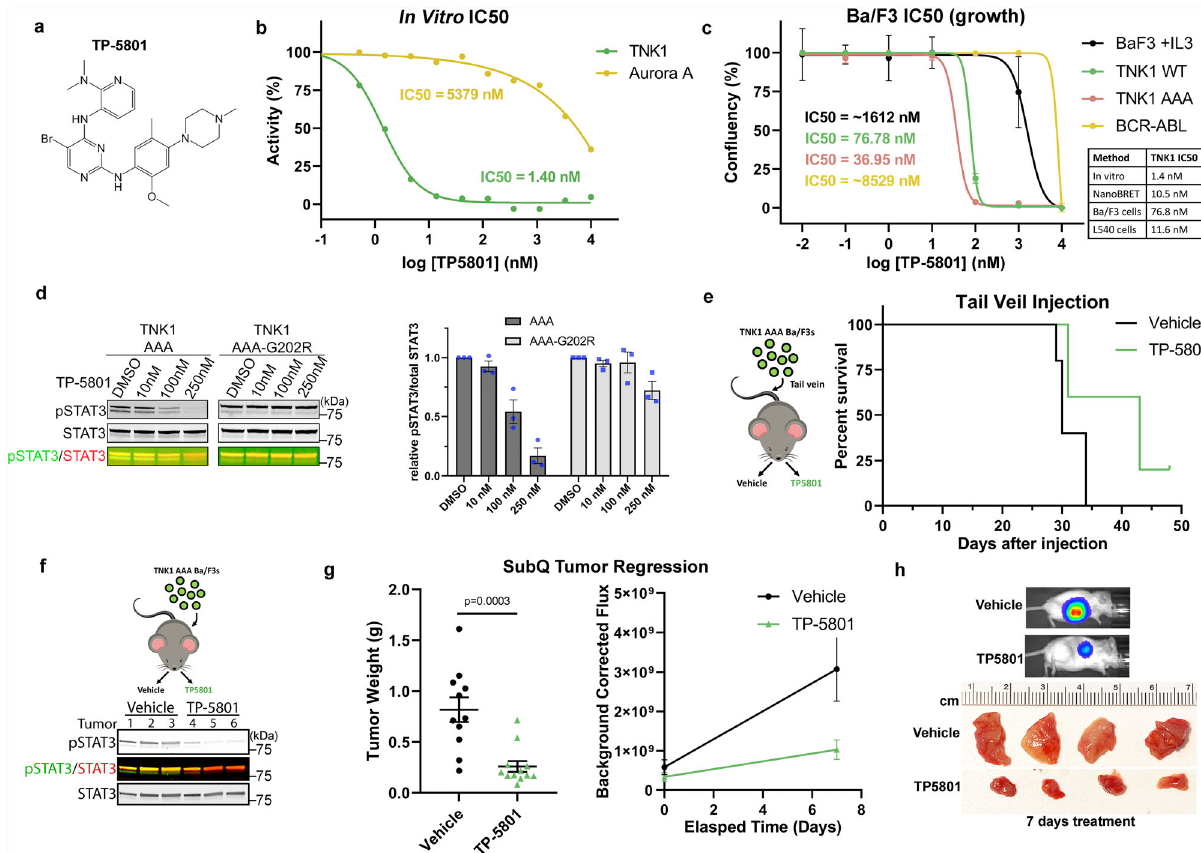
Fig. 6 The development of a potent TNK1 inhibitor that reduces tumor burden and extends life span in a TNK1-driven tumor model. a Chemical structure of TP-5801. b Recombinant kinases were incubated with a 3-fold serial dilution of TP-5801 starting at 1 – 10 μ M. Reactions were carried out at Km ATP for each enzyme (5 µ M for TNK1, 10 µ M for Aurora A, 50 µ M for ALK) in the presence of 33-P labeled ATP. The resulting % enzyme activity (relative to DMSO controls) were plotted and IC50 values were determined by sigmoidal dose-response (variable slope) curve fi ts with a bottom constraint of 0. c IC50 graph of IL-3 driven Ba/F3 cells, TNK1-WT/AAA driven Ba/F3 cells, or BCR-ABL-driven Ba/F3 cells treated with TP-5801(10 pM to 10 mM) for 72 h. Cell con fl uency was measured using the IncuCyte imaging system. Graph shows mean con fl uency with error bars representing SEM from three replicates. (Bottom Right) Table summary of the IC50 values of TP-5801 obtained by different methods. d TNK1-AAA or TNK1-AAA-G202R driven Ba/F3 cells were treated with vehicle (DMSO) or indicated concentrations of TP-5801 for 4 h. The cell lysate was immunoblotted for phospho-STAT3 (pY705) and total STAT3. Graphs show quanti fi cation from multiple biological replicates ( n = 3) with error bars representing SEM. e 1 × 10 6 TNK1-AAA driven Ba/ F3-luc cells were injected into the tail vein of NOD/SCID mice ( n = 5 for each group). The mice were treated once daily by oral gavage with either vehicle Once tumor size reached 150 – 250 mm 3 , mice ( n = 3 for each group) were treated with either vehicle or 50 mg/kg TP-5801 by oral gavage. Mice were euthanized 2 h after treatment and tumors were resected. Tumors were lysed and immunoblotted for phospho-STAT3 (pY705) and total STAT3. g NOD/ SCID mice were subcutaneously injected with TNK1-AAA driven Ba/F3-luc cells. Once tumor size reached 150 – 250mm 3 , mice ( n = 10 for each group) were treated once daily by oral gavage with either vehicle or 50 mg/kg TP-5801 for seven days. Luminescent signal was imaged and quanti fi ed using IVIS imaging. Mice were euthanized after a one-week treatment and tumors were resected and weighed. The box plot shows median, fi rst and third quartile of tumor weight. P -values were calculated using a two-tailed student t -test. The mean corrected luminescent signal is shown on the right graph with error bars representing SEM. h Images show the luminescent signal from panel g and resected tumors after one week of treatment. Source data are provided as a Source Data fi